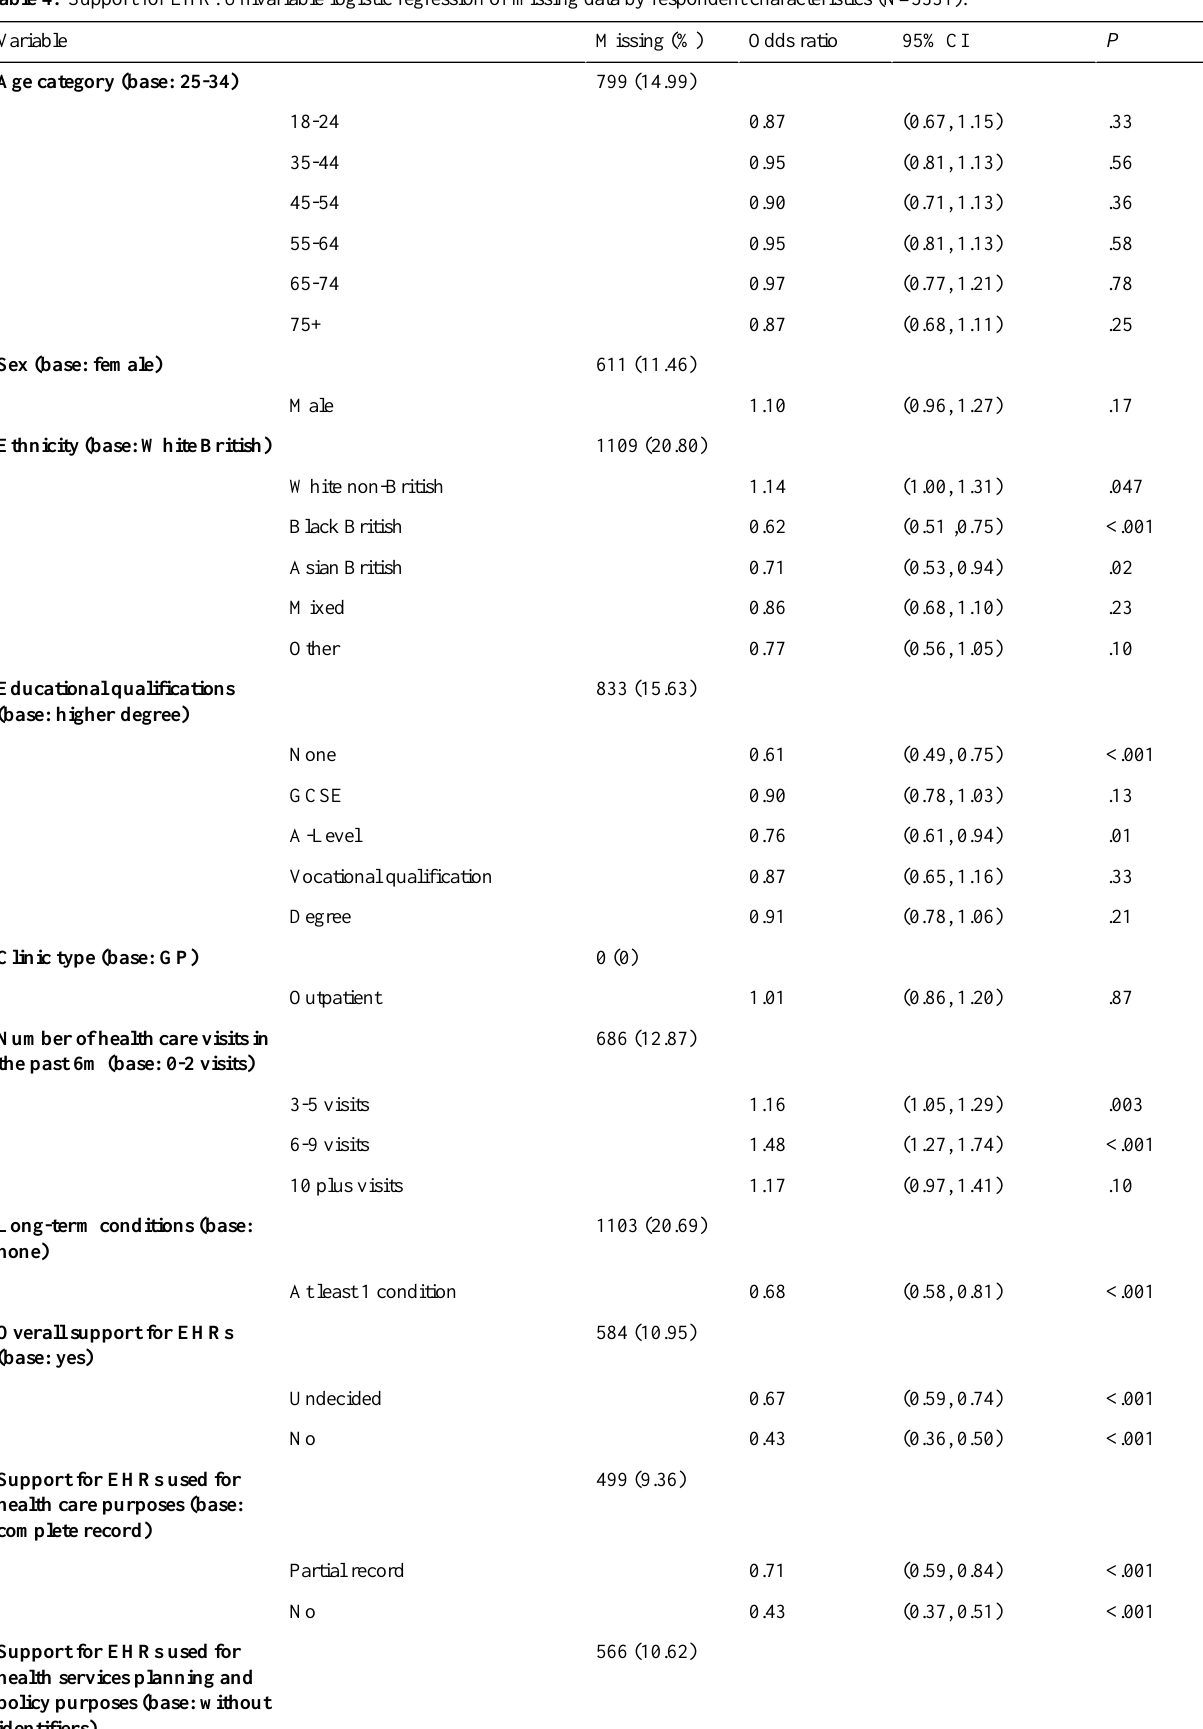
Table 4. Support for EHR: Univariable logistic regression of missing data by respondent characteristics